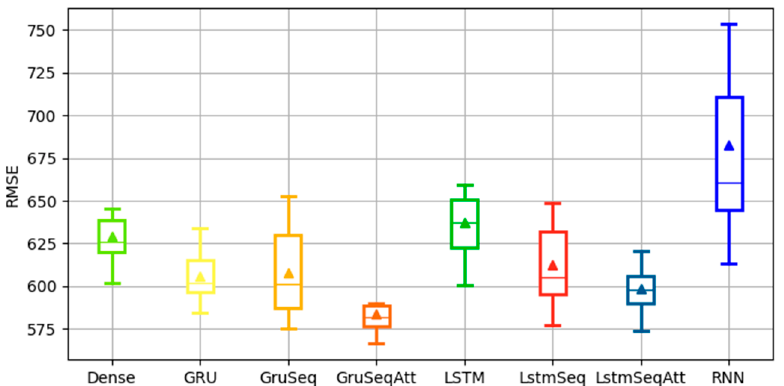
Figure 5. RMSE box line diagram for different models.